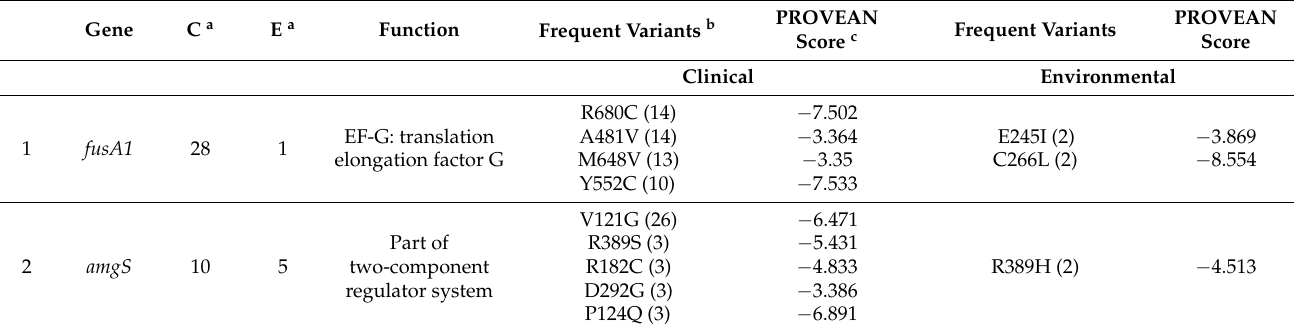
Table 1. Frequency of sequence variants in clinical and environmental isolates of P. aeruginosa .